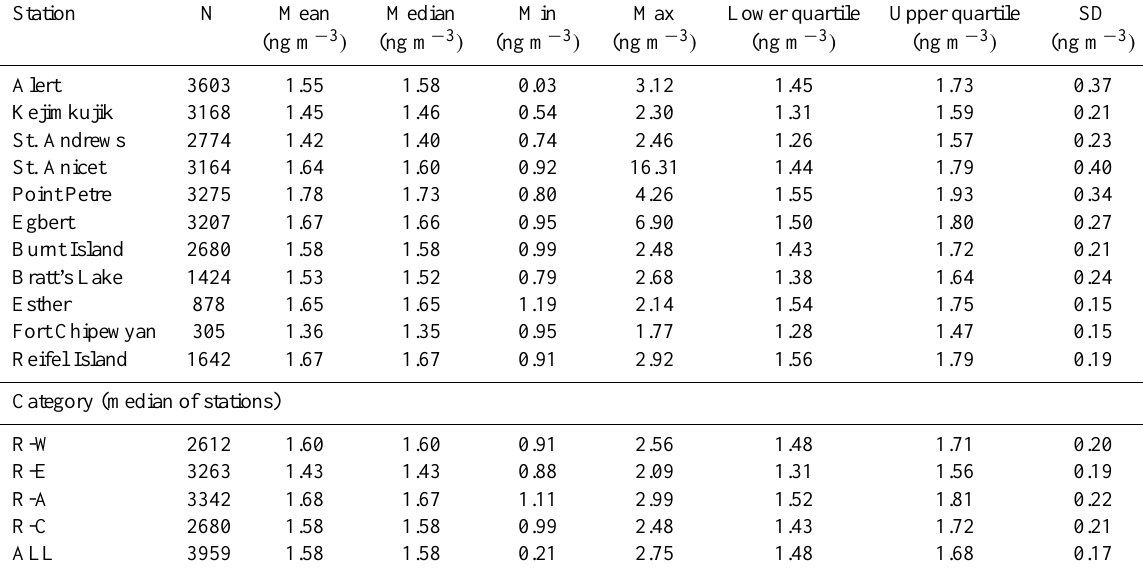
Table 4. Statistical summary of TGM measurements at CAMNet sites. R-W means RURAL-WEST (RFL, EST, FCH, BRL); R-E:RURAL- EAST (KEI, STA); R-A: RURAL-AFFECTED (WBZ,PPT, EGB); R-C: RURAL-CENTRAL